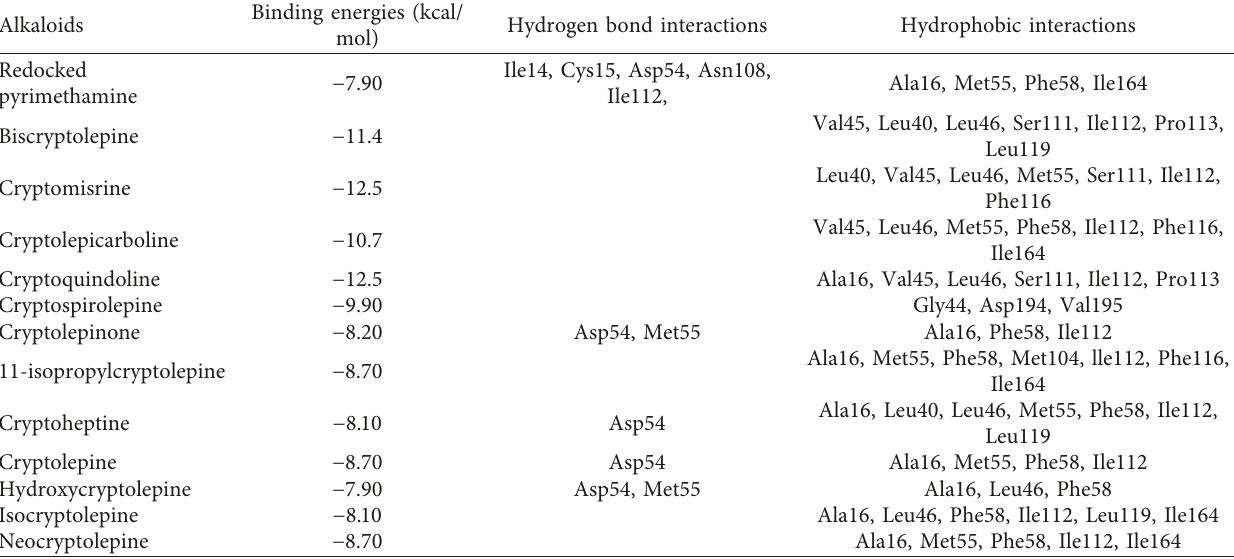
Table 3: Molecular docking result of pyrimethamine and Cryptolepis sanguinolenta alkaloids with double mutant Pf DHFR (1J3J). Binding energies (kcal/ Alkaloids Hydrogen bond interactions mol)